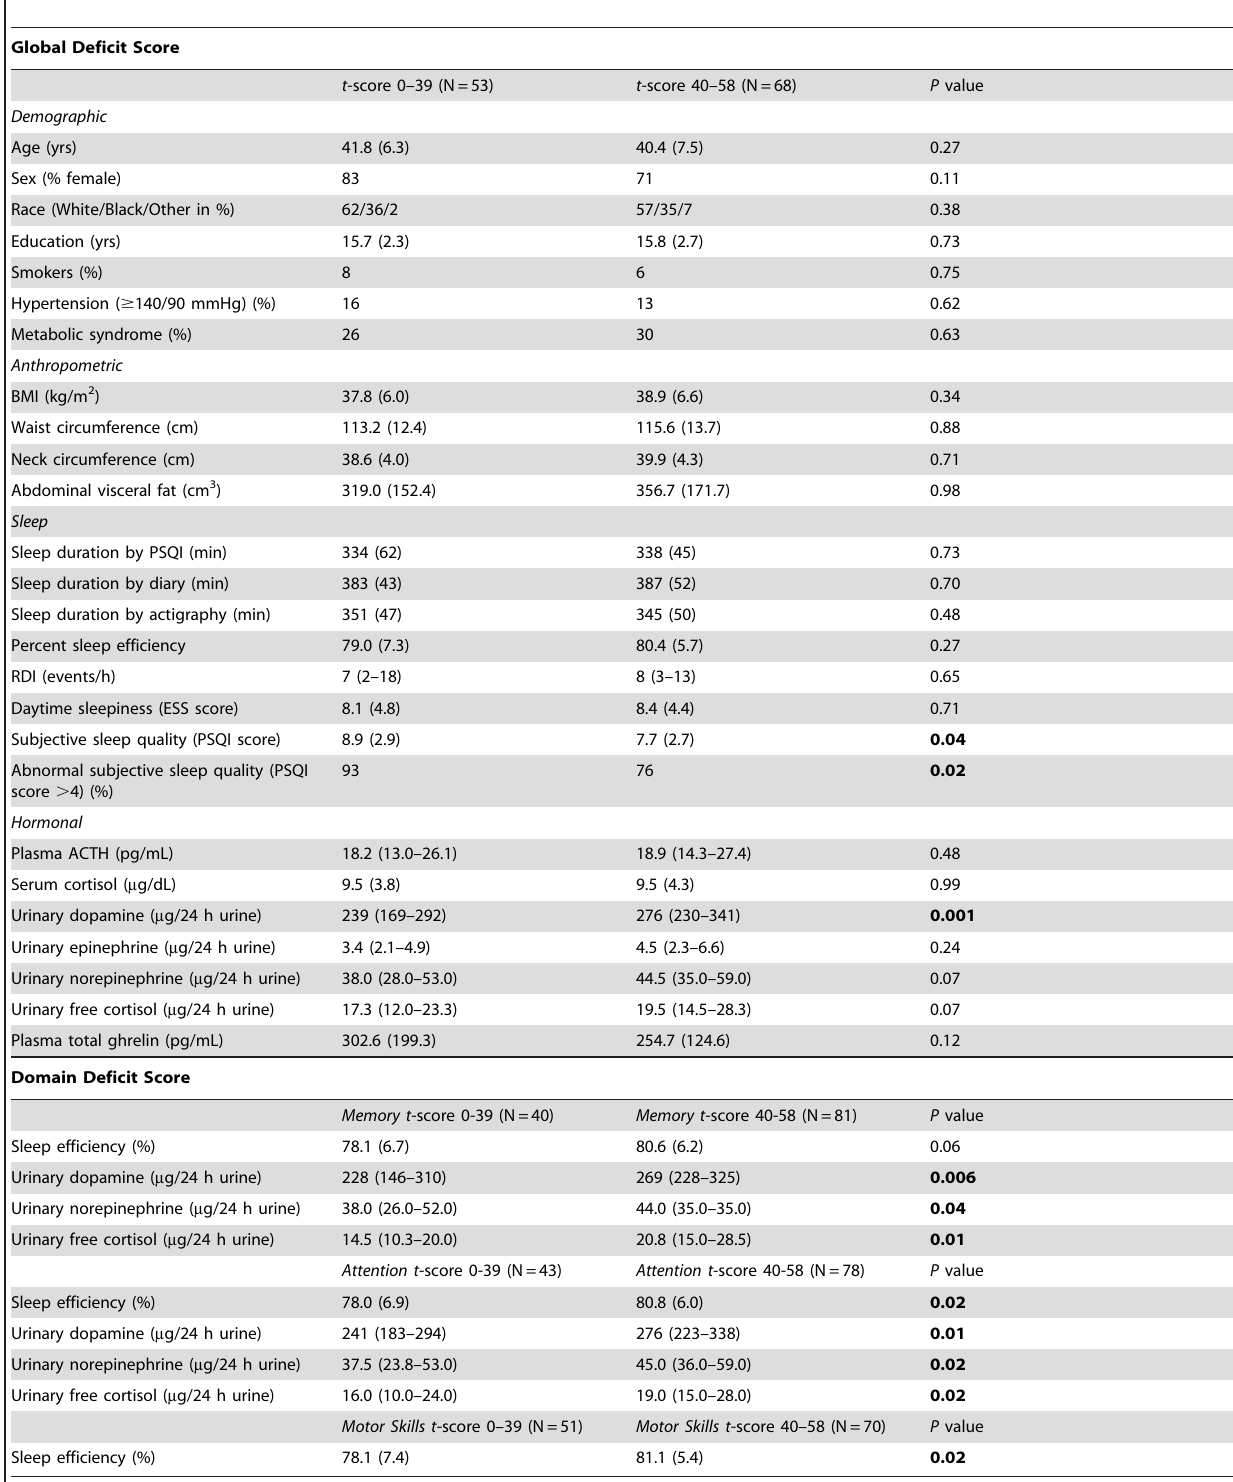
Table 1. Baseline characteristics of individuals according to Global Deficit Score and Domain Deficit Score